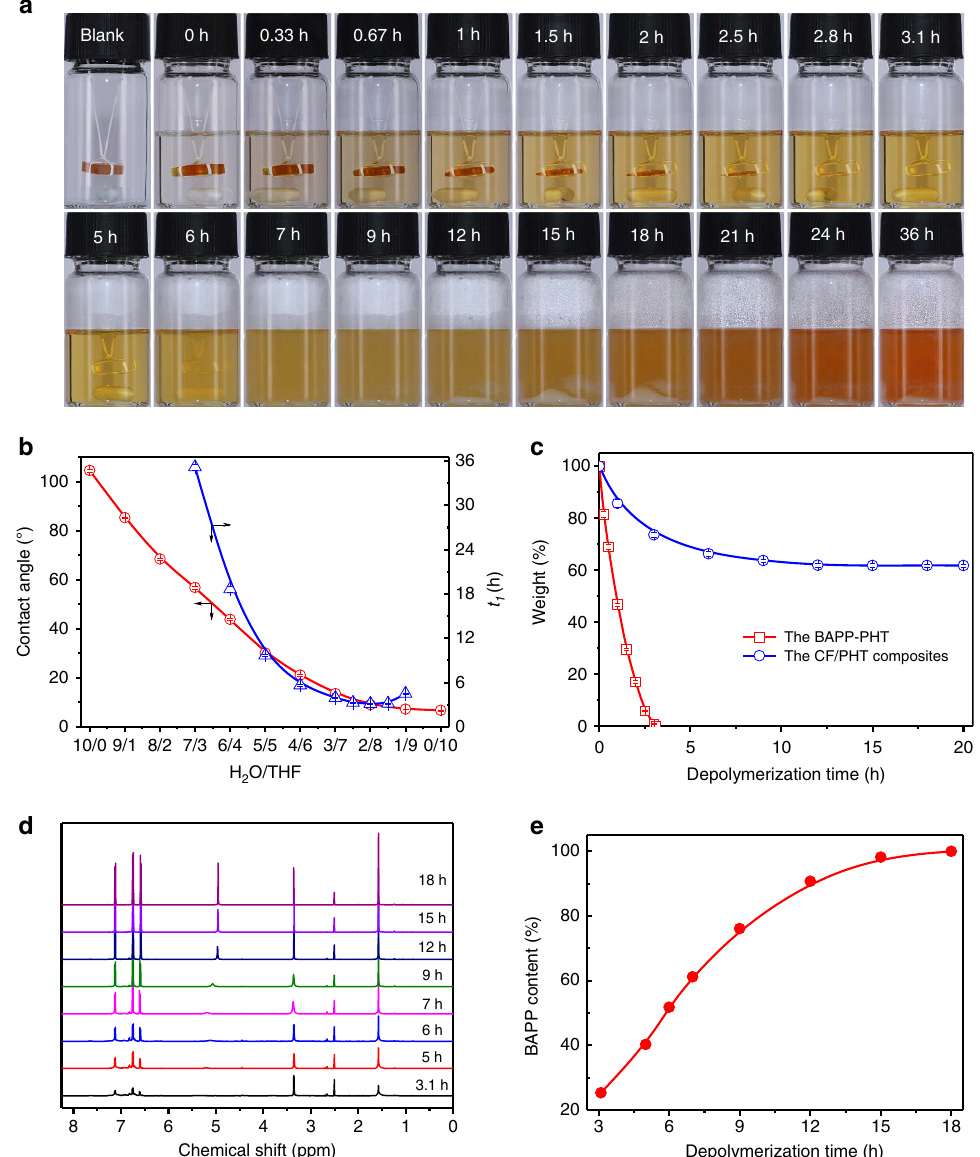
Figure 3 | Depolymerization and recovery of the BAPP-PHT at room temperature. ( a ) The resin’s degradation status in 10ml 1M HCl/THF solution at different times; ( b ) The resin’s first-stage depolymerization time ( t 1 ) in different 1M HCl/THF solutions and the contact angles of their corresponding H 2 O/ THF solutions; ( c ) The depolymerization kinetics of the BAPP-PHT and the CF/PHT composite in 1M HCl/THF solution (specimen size: 1cm (cid:4) 1cm (cid:4) 3mm); ( d ) 1 H NMR spectra of the depolymerized products of the BAPP-PHT in 1M HCl/THF solution at different times; ( e ) The generation curve of